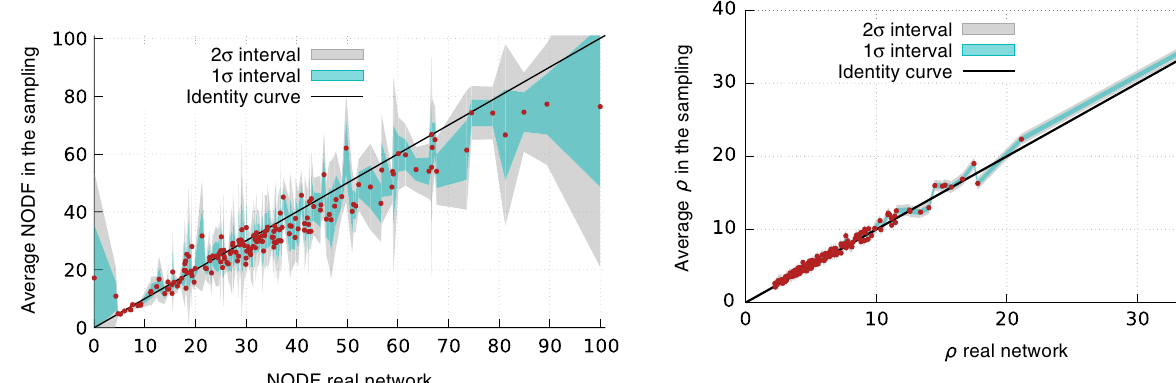
FIG. 11. Comparison between the real observation of the spectral radius ρ ð λ Þ and the average estimated over a sampling of the statistical ensemble formed by 10 4 networks for the 167 networks of our